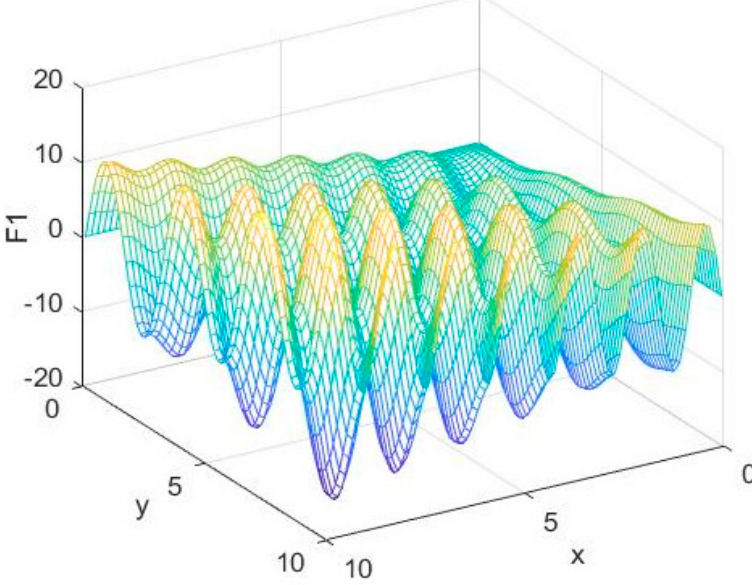
Figure 12. First-used test function.